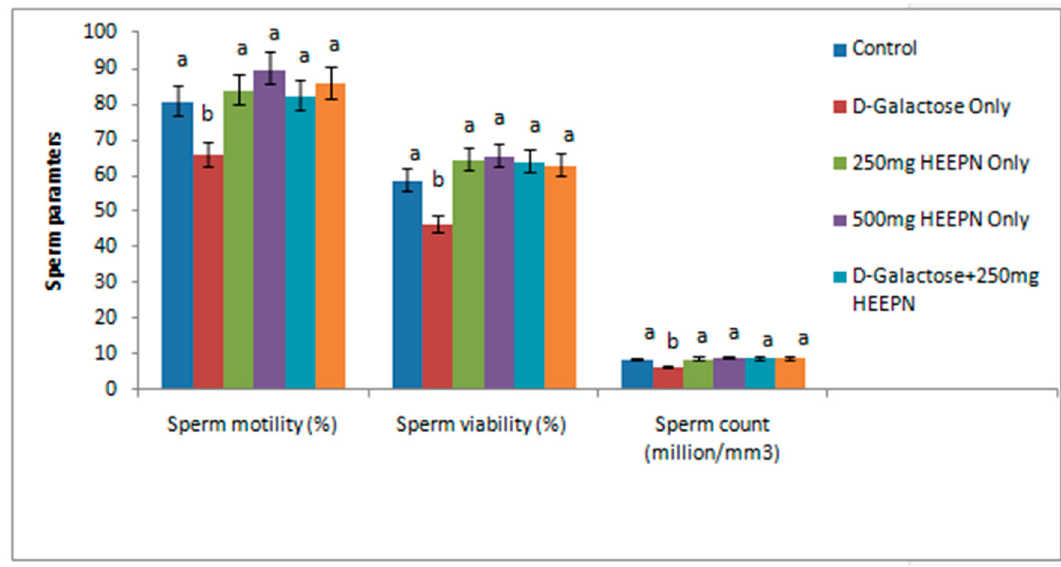
Figure 1. Effect of graded doses of hydroethanolic extract of P. nigrescens on sperm parameters. Values are means of five replicates ± SEM. Bars carrying different superscripts (a, b) are significantly different at p < 0.05.